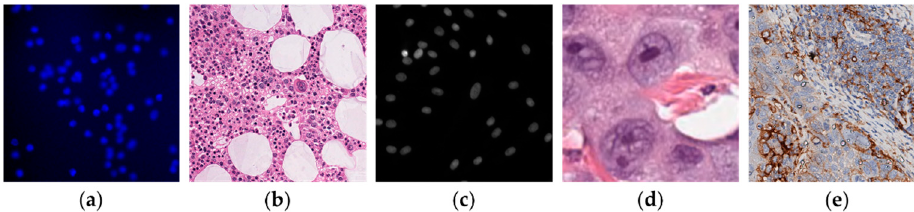
Figure 7. Five sets of cell images, ( a ) BCFM, ( b ) BM ( c ) Kaggle, ( d ) PanNuke, and ( e ) LUSC.